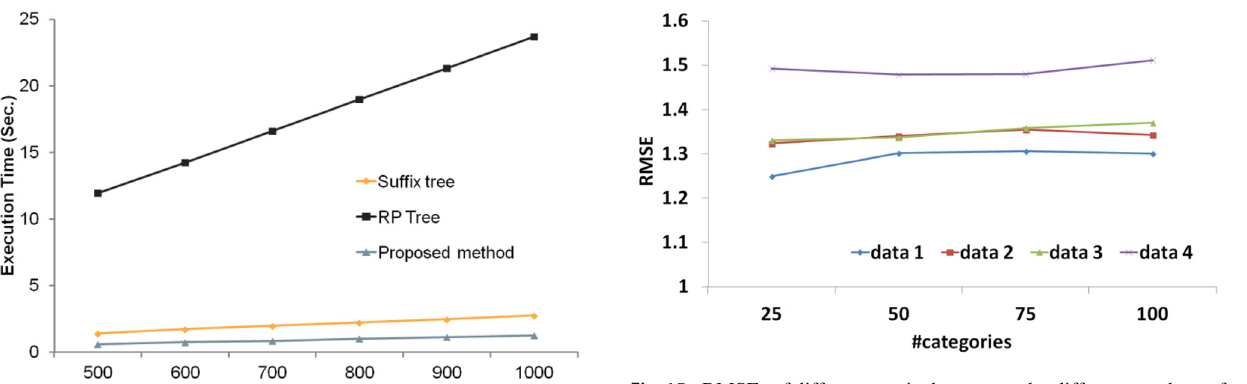
Fig.15 RMSEs of different music data sets under different numbers of pattern